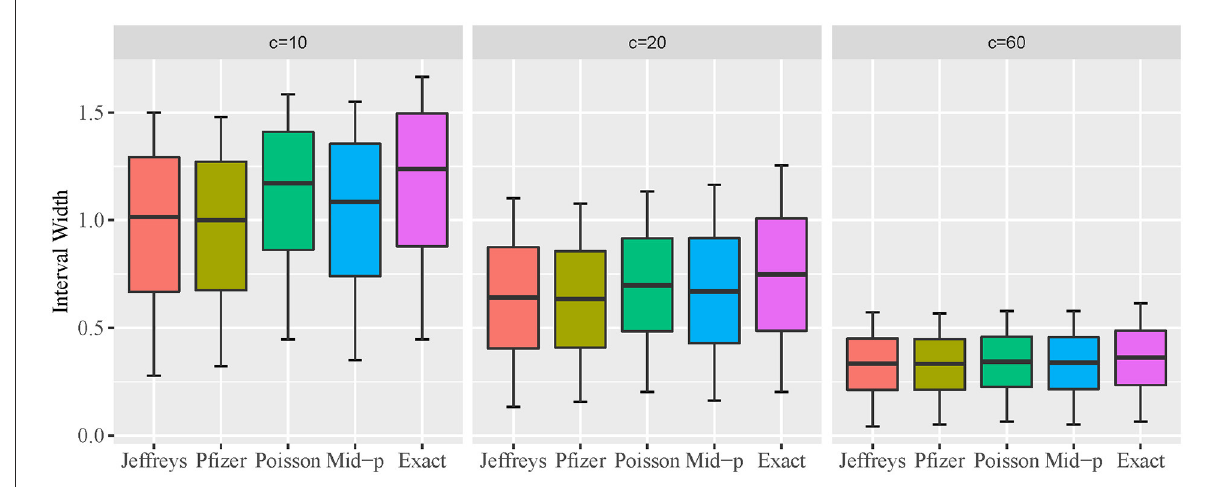
FIGURE3 Box plot of expected two-sided interval width for different VE intervals.